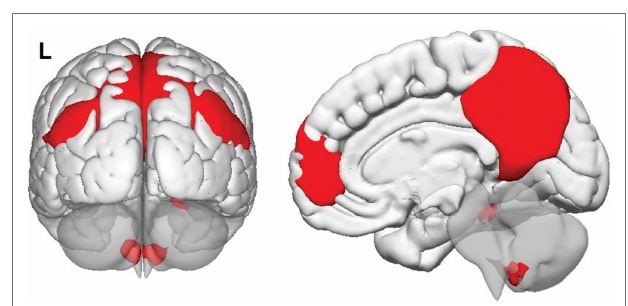
FIGURE 2 | Group-level map of default-mode network in the sample, as calculated by independent component